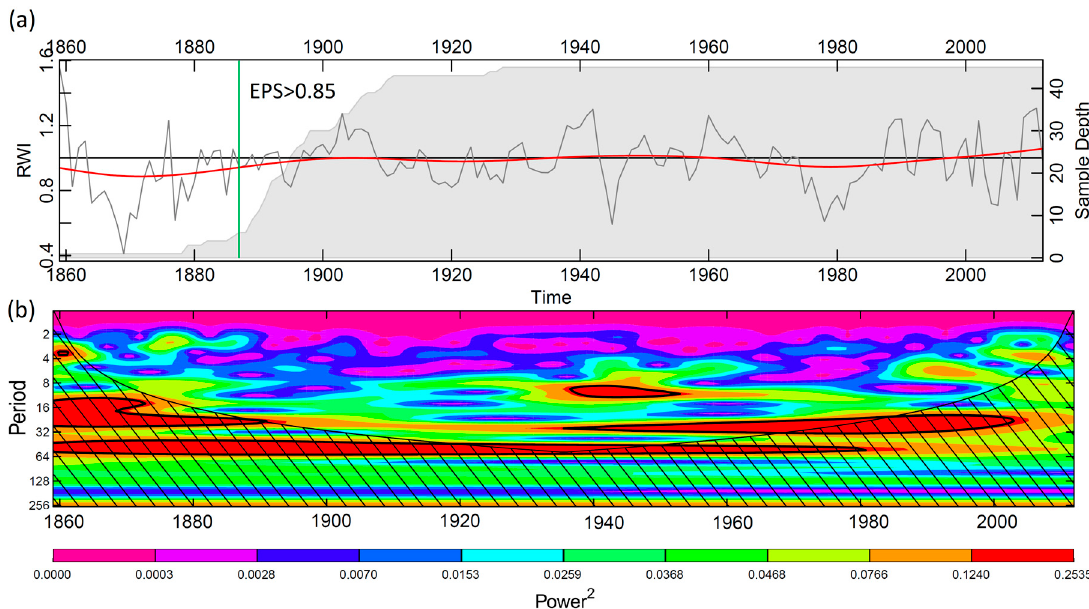
Figure 4. ( a ) Manas TRW chronology (STD) detrended using a 30-spline curve and the sample depths with respect to time (red line); the green line represents the expressed population signal (EPS) > 0.85. ( b ) The wavelet power spectrum. The contour levels were chosen so that 75%, 50%, 25% and 5% of the wavelet power is above each level, respectively. The black contour is the 1% significance level with a red noise (autoregressive lag1) background spectrum. RWI refers to ring width index.